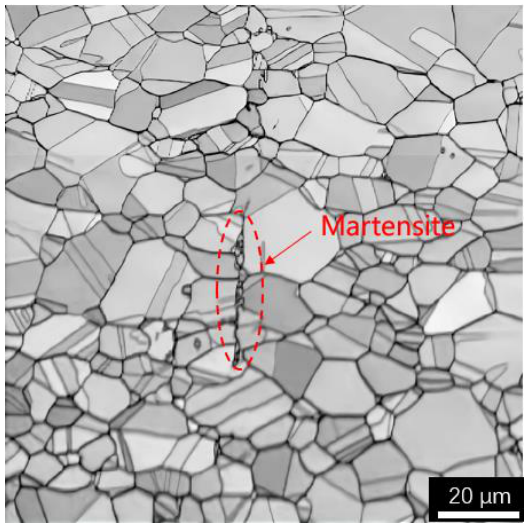
Table 1. Chemical composition in weight percentage of the AISI 316L hot rolled plate. Figure 1. ( a ) Cyclic shear fatigue testing machine, ( b ) twin bridge shear specimen.